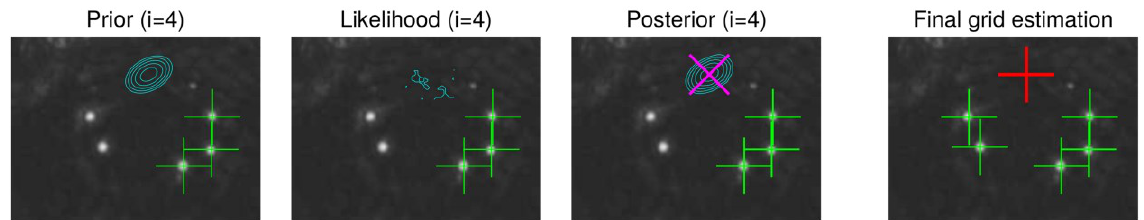
Figure 8. An illustrative example of locating an occluded glint. The topmost glint is occluded by the eyelid. The parti- cle has successfully estimated three components. Since there is no visible glint where the fourth glint is supposed to be according to the prior model, the likelihood is approximately flat and the posterior equals the prior (up to a scaling factor). The remaining two glints are again successfully located. The rightmost image shows the estimated grid lo- cation. The red thick plus sign indicates a low intensity value at the corresponding glint